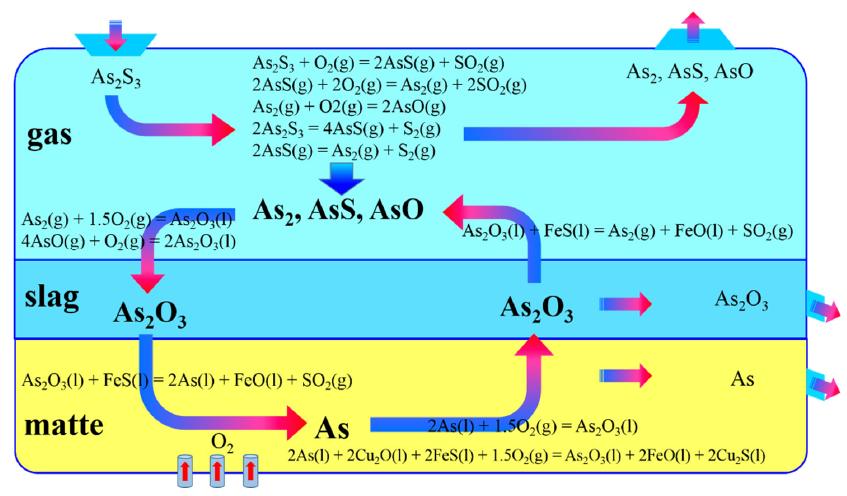
Figure 4. Reaction mechanism and mass transfer behavior of arsenic in the SKS process.